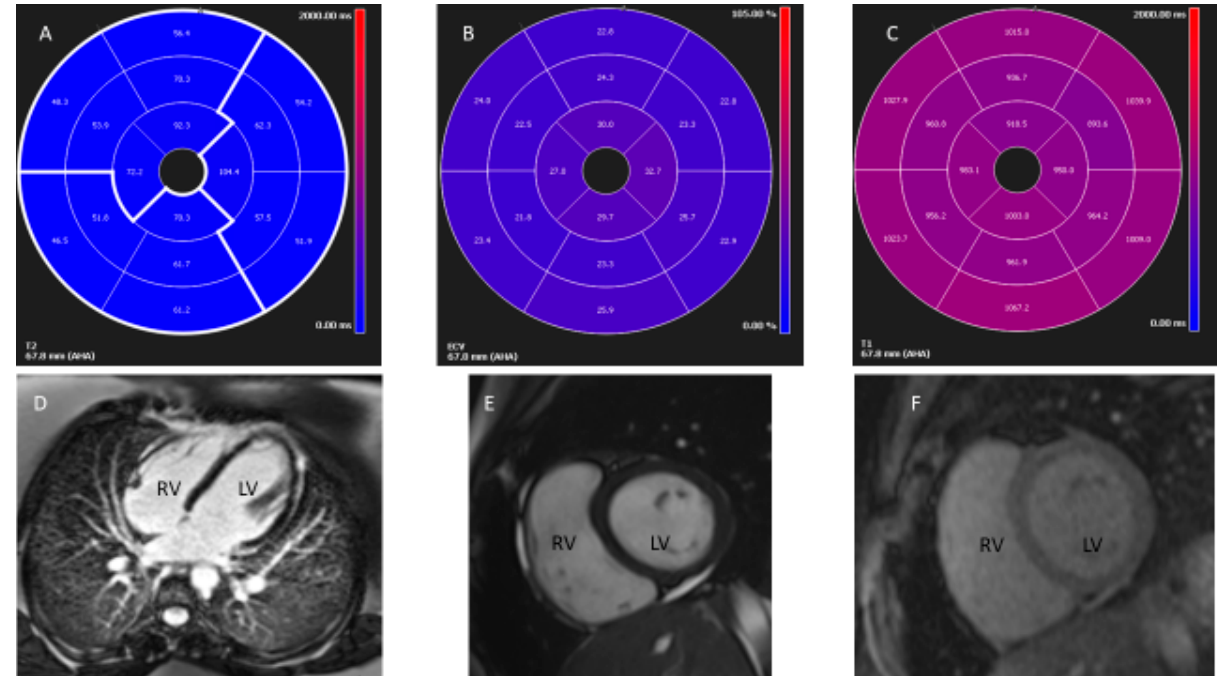
Figure 2. Cardiac magnetic resonance imaging showing the diagnosis of myocarditis. Cardiac magnetic resonance imaging: ( A ) T2 mapping showed elevated myocardial relaxation time consistent with patchy edema; values for the T2 ratio compared to skeletal muscle >2.4; ( B ) T1 mapping showed normal extracellular fluid volume; ( C ) T1 mapping showed no myocardial fibrosis; ( D ) Normal size left and right ventricles, normal lung parenchyma and branch pulmonary arteries; ( E ) absence of early gadolinium enhancement; and ( F ) absence of delayed myocardial